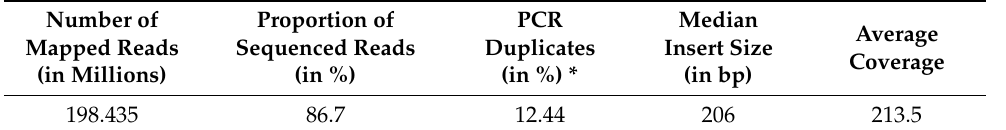
Table 1. Statistics of mapped reads